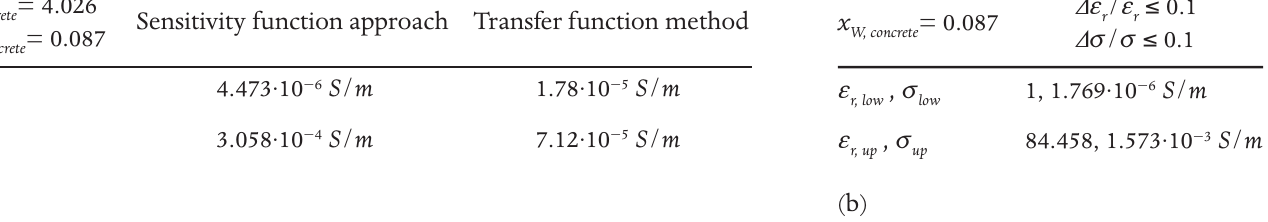
and designed optimally r, concrete